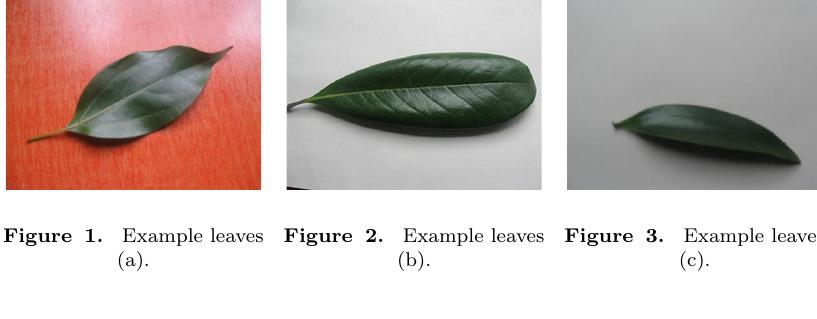
Figure 3. Example leaves (c).